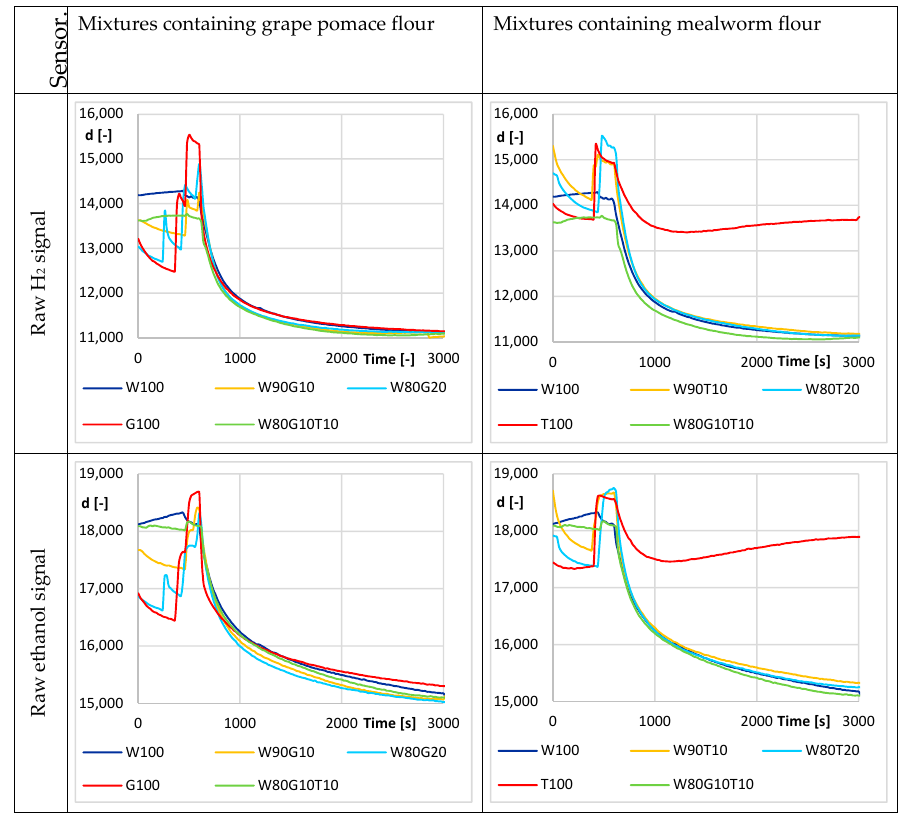
Figure 6. Fermentation process—average sensor response SGP-30 for different flour mixtures (W— wheat flour, G—grape pomace flour, T—mealworm flour). Mixed sample inserted at t = 600 s.